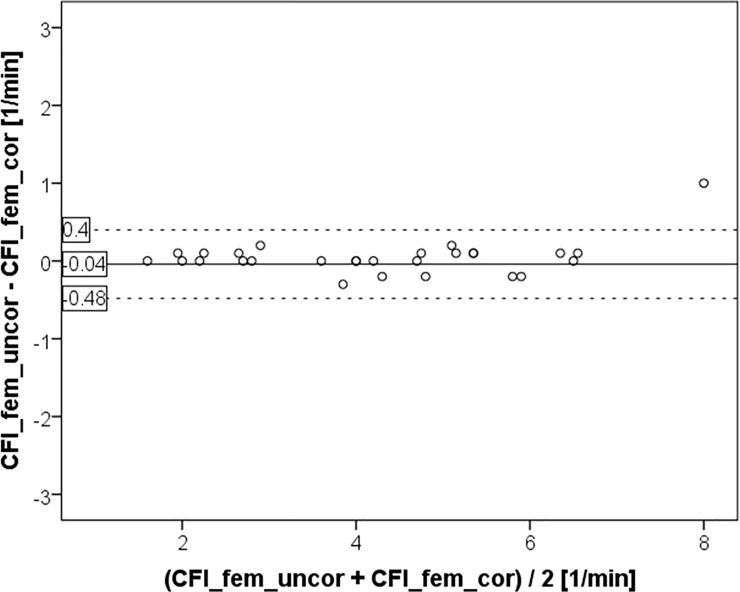
Bland Altman plot comparing cardiac function index CFI derived from femoral indicator injection with (CFI_fem_cor) and without (CFI_fem_uncor) activation of a potential correction by the device.